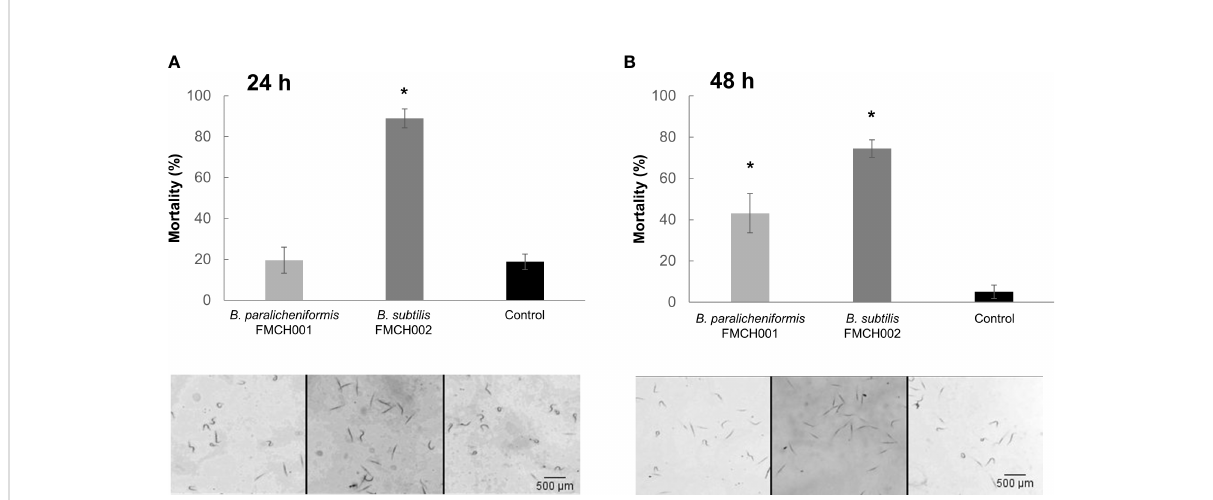
FIGURE 2 Effect of bacteria supernatants free of bacterial cells on the mortality of Meloidogyne incognita . Percentage of dead nematodes treated with supernatant of bacteria B paralicheniformis FMCH001; B subtilis FMCH002 as indicated, grown in MSgg for (A) 24 h and (B) 48 h. In the panels below, representative images of the nematodes shape in each of the bacteria treatments and the control. Curled nematodes are alive, straight nematodes, dead. Nematodes were monitored after 24 hours. MSgg media was used as control. 100 J2s were tested per treatment with three biological replicates. Bars represent mean ± SE. *Asterisks, signi fi cant differences respect to control (t-test; p < 0.05). Scale bar: